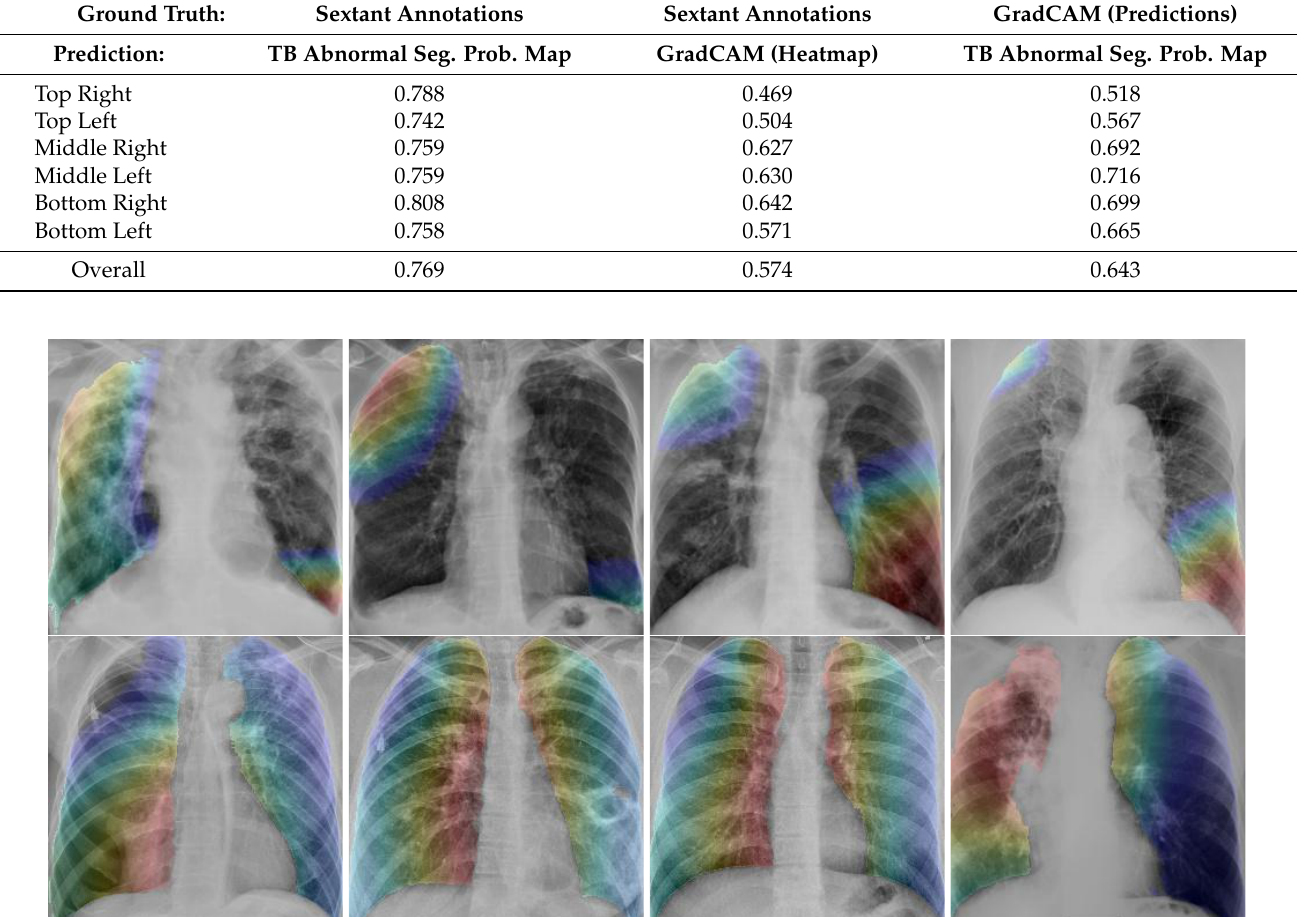
Table 7. Comparison (AUC) of localized abnormalities from different sources tested on Belarus dataset.